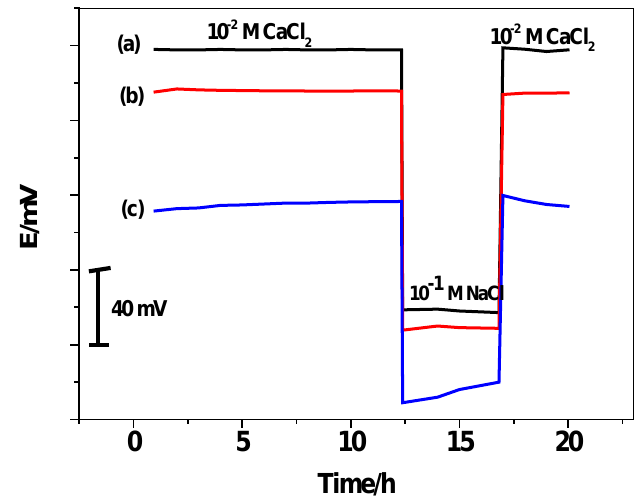
Figure 6. Water-layer test for ( a ) C / GO / Ca 2 + -ISEs; ( b ) C / PPY / Ca 2 + -ISEs; and ( c ) C / Ca 2 + -ISEs. Table 4. Assessment of Calcium content in some baby-food products and pharmaceutical formulations. Potentiometry AAS Labeled Amount Sample mg / tab. or mg / g mg / tab. or Cap.